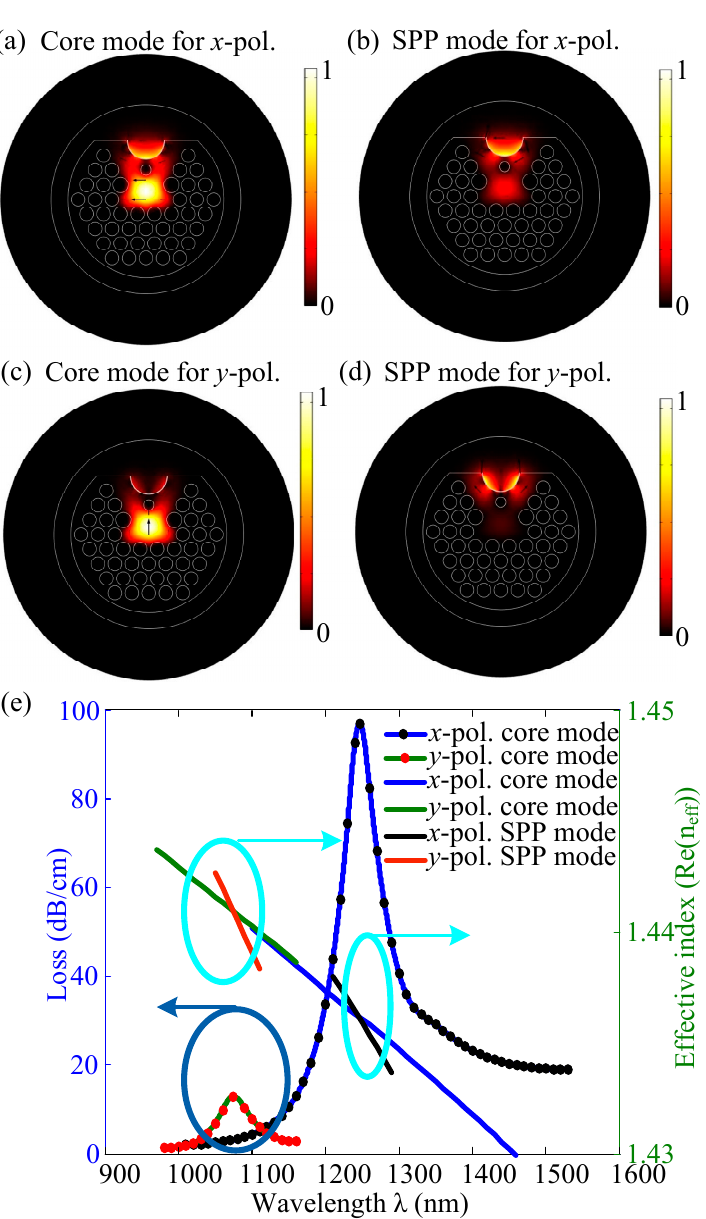
Figure 3. Electric field distribution of x -polarized ( a ) core, ( b ) SPP mode, y -polarized ( c ) core, and ( d ) SPP mode; ( e )confinement loss spectrum for both x - and y -polarization as a function of wavelength for analyte RI of 1.43; dispersion relation of core and SPP mode for both x - and y -polarization. The propagation loss spectra of the x -polarized fundamental mode are shown in Figure 4a due to the medium placed in the channel with RI ranging from 1.33 to 1.44. The increase in the analyte RI results in the reduction in core-cladding index contrast; as a result, resonant wavelength redshifts and peak confinement loss raises. The resonant wavelengths and peak confinement losses are shown in Table 1 for different analyte RI. The loss spectrum for higher analyte RI (e.g., 1.44) shows multiple resonance peaks at longer wavelengths similar to the Ref. in [38], where only the largest peak loss is considered to find the resonant wavelength. The higher peak loss is considered due to larger energy transmission from the core mode to SPP mode compared with the other